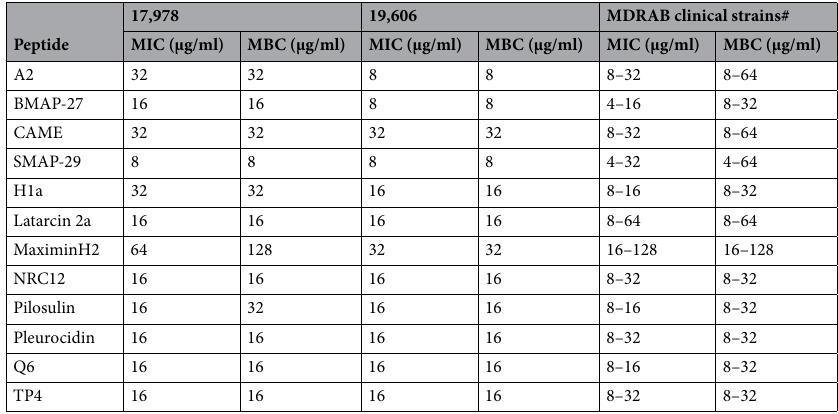
Table 1. Minimal inhibitory concentration (MIC) and minimal bactericidal concentration (MBC) of antimicrobial peptides against Acinetobacter baumannii 17,978, 19,606 and multiple drug-resistant (MDR) clinical strains. # Details are available in Supplementary Table